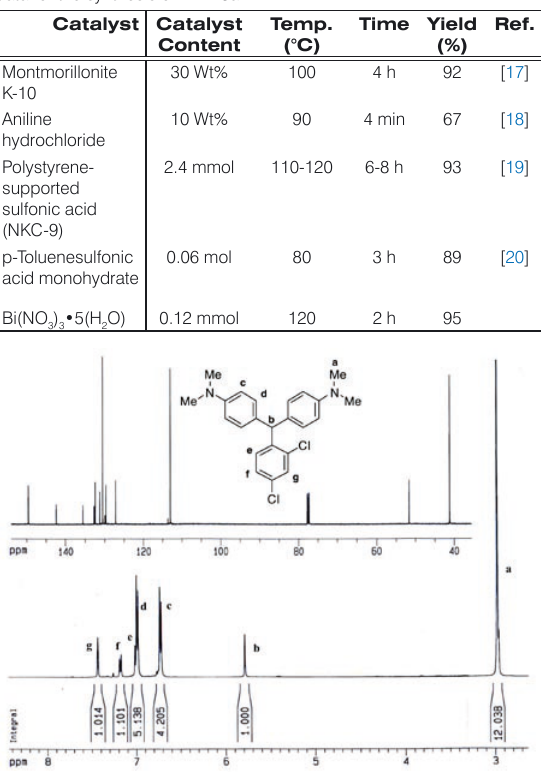
1. The 1H NMR and 13C NMR spectra of 4,4’-diaminotriarylmethane compound